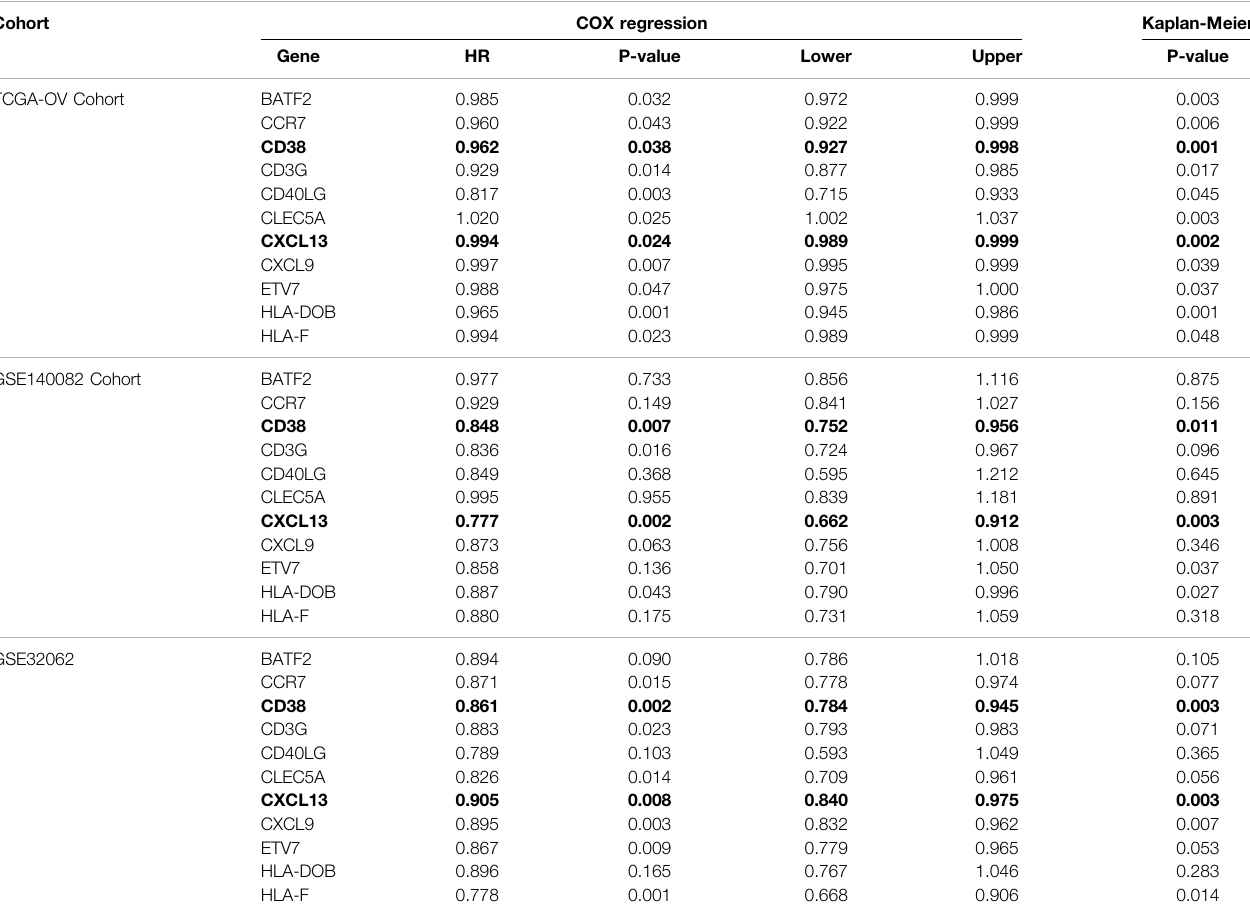
TABLE 1 | Univariate COX regression and K-M survival analyses of 11 CD8 + T cell related genes in TCGA-OV, GSE140082, and GSE32062 cohorts. Cohort COX